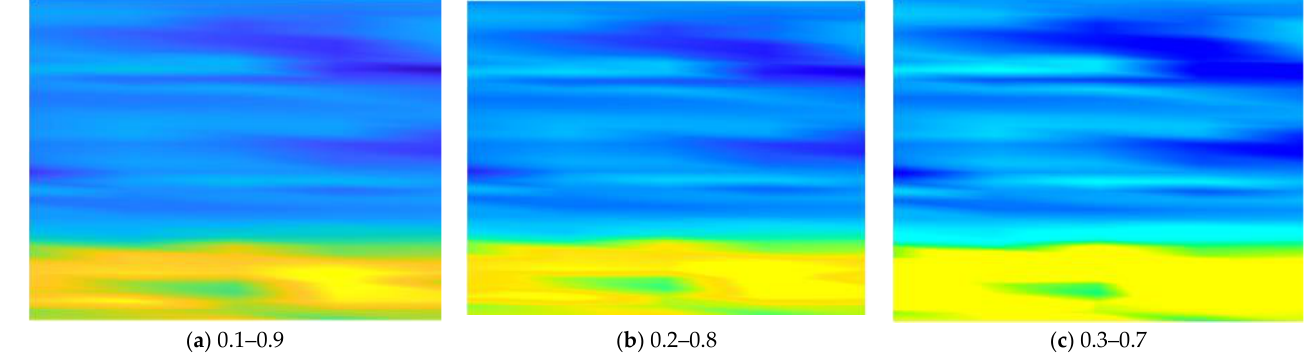
Figure 14. Tug image samples at different contrast ranges.